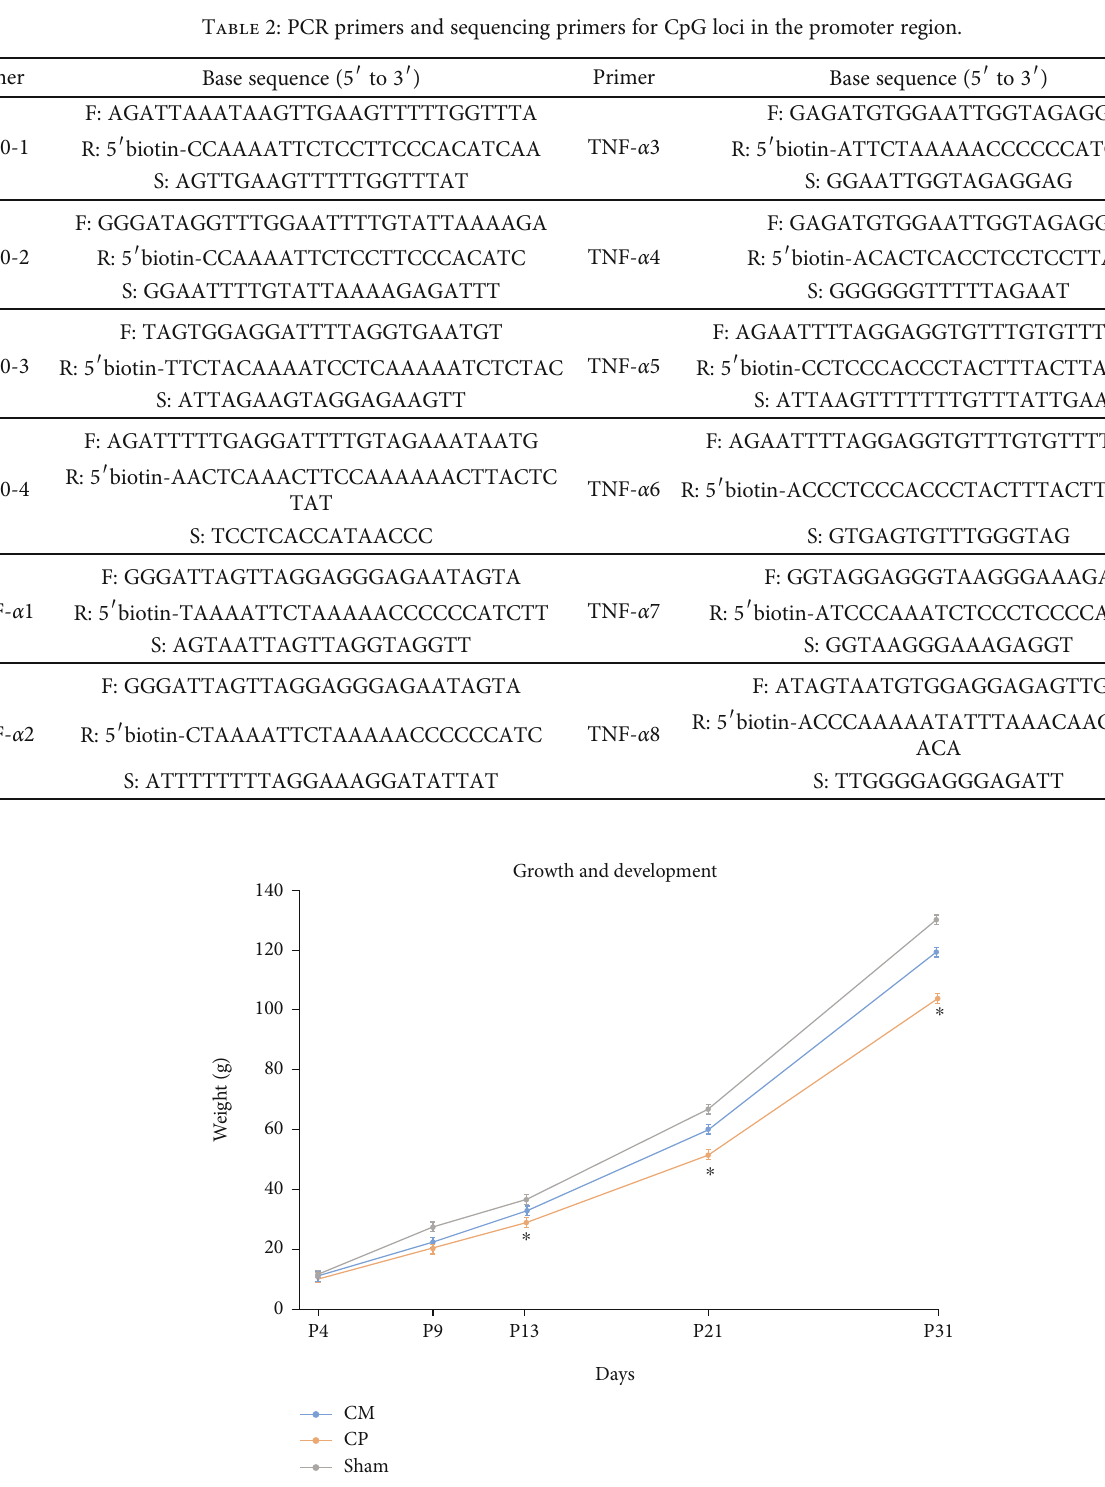
Figure 1: Chinese Tuina promoted growth and development in rats with HIE. ∗ P < 0 : 05 , comparison with the HIE group, n = 10